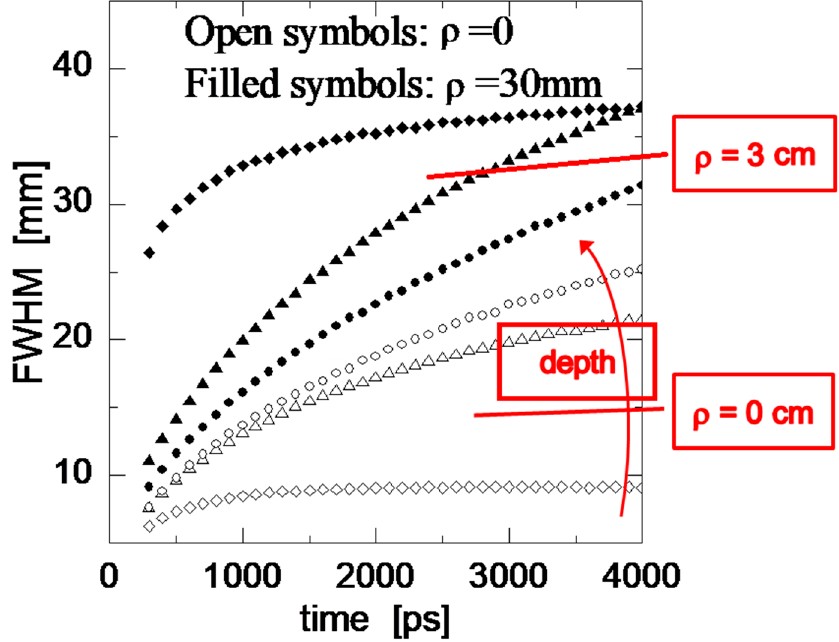
Figure 5. The ρ = 0 case improves spatial resolution at all times with respect to a larger ρ (modified from [38]).